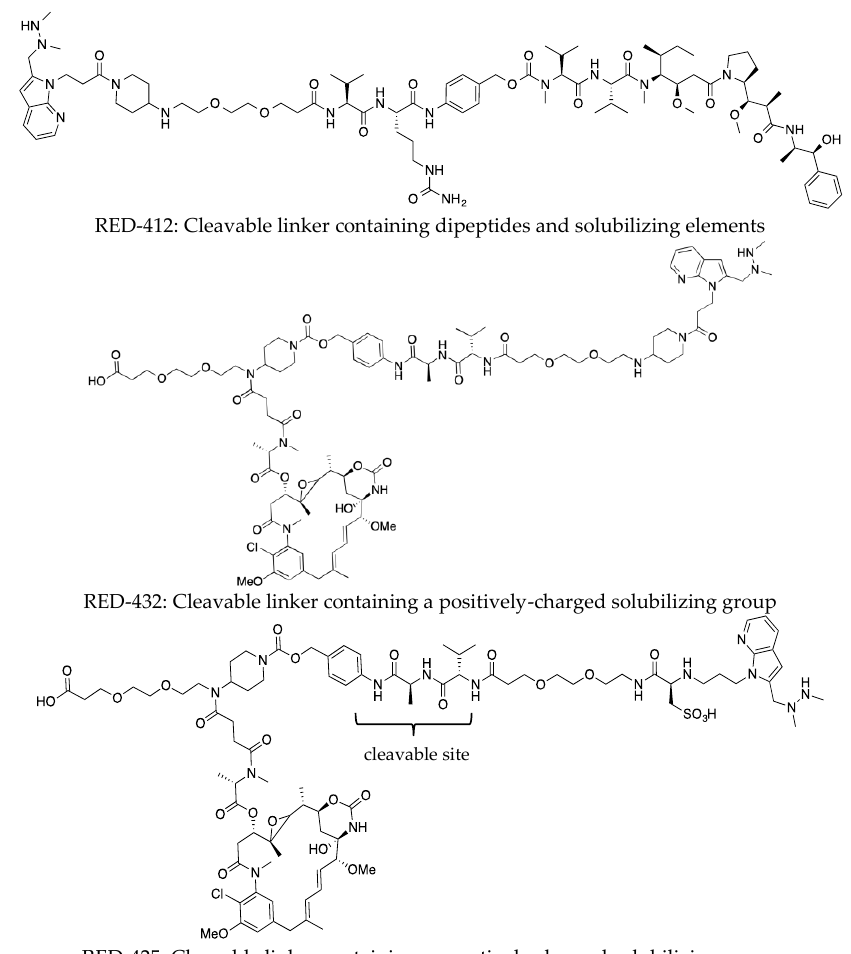
Figure 2. Design of antibody-drug conjugates. ( a ) Schematic of the components of site-specifically modified 2G10 anti-uPAR ADC. Antibodies carrying aldehyde moieties (DAR of 2 or 4) are reacted with a Hydrazino-iso-Pictet-Spengler (HIPS) linker / payload to generate a site-specifically conjugated ADC. Inhibitors of tubulin polymerization (maytansine, monomethyl auristatin E, MMAE) linked to cleavable or non-cleavable linkers. ( b ) The chemical composition of the linkers. Only RED-106 is non-cleavable. Immunofluorescence microscopy was used to localize the 2G10 within MDA-MB-231 cells. We had previously shown that 2G10 does not internalize to MCF7 cells [19]. Lysosomes, visualized using LysoTracker (green signal) were distinct and punctate. MDA-MB-231 incubated with LysoTracker ◦ and 2G10-AF647 (red signal), 10 µ g / mL, 1 h at 37 C), and resulted in a yellow signal